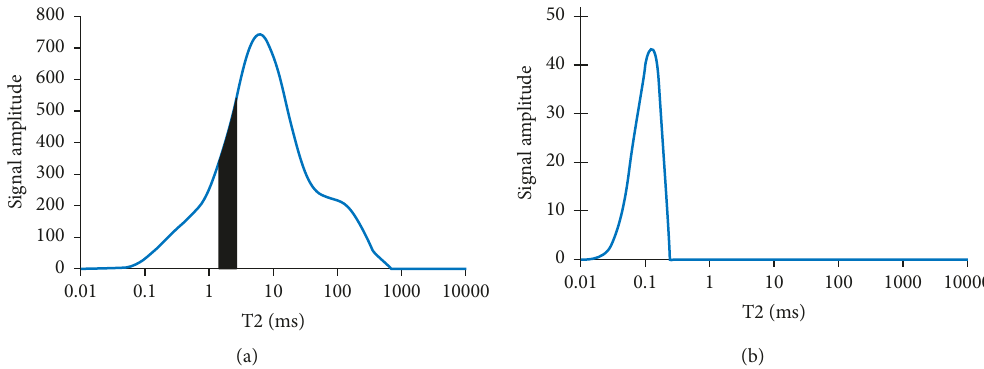
Figure 5: Results of nuclear magnetic resonance imaging. (a) Briquette sample; (b) coal